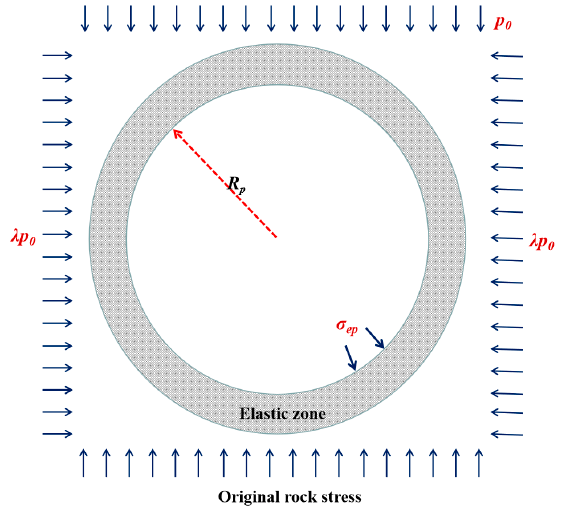
Figure 2. Equivalent model of elastic zone for tunnel surrounding rock